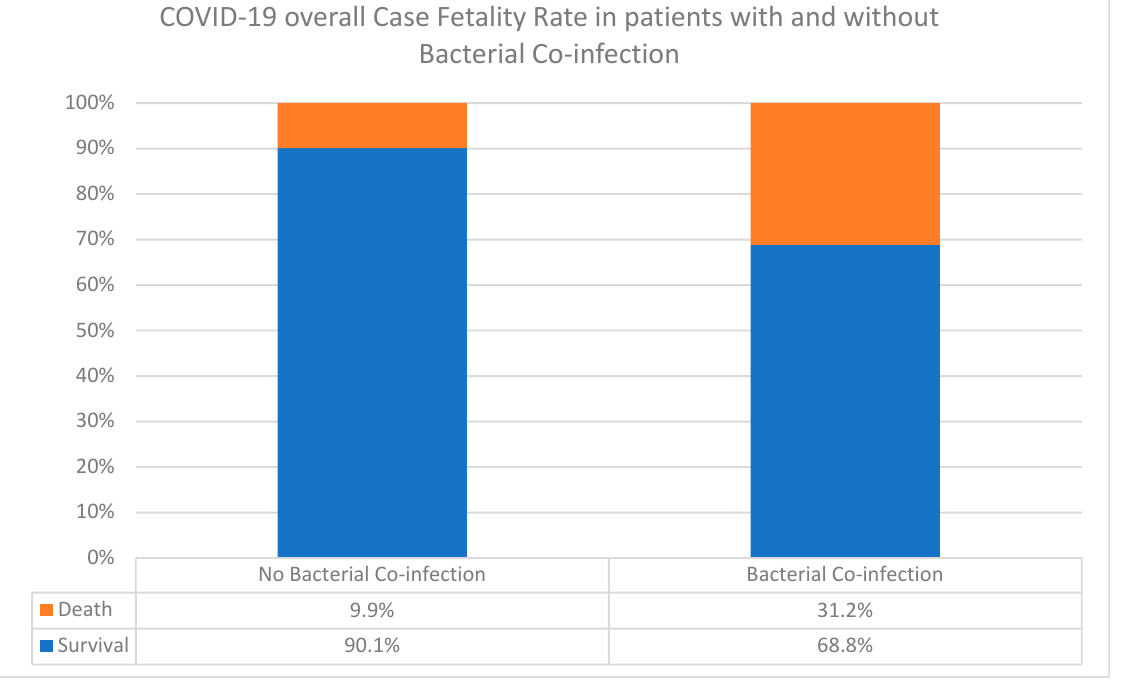
Figure 6. Overall COVID-19 case fatality rate in 301 patients with and without secondary bacterial co-infections in the Ha’il region, Saudi Arabia.